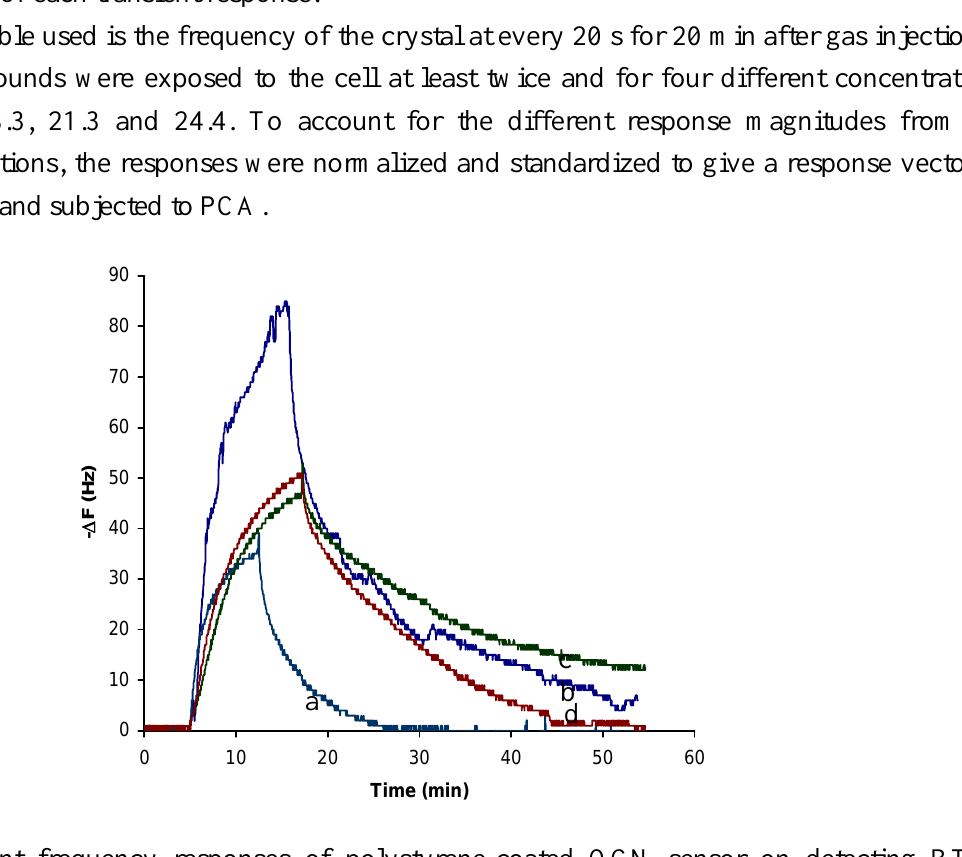
Figure 8. Transient frequency responses of polystyrene-coated QCN sensor on detecting BTEX compounds. a) benzene, b) toluene, c) ethylbenzene, d) xylene.